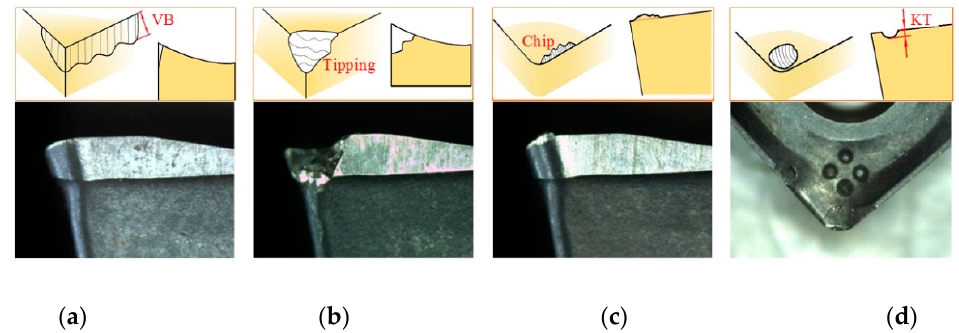
Figure 6. Form of tool wear and tool breakage ( a ) Flank wear; ( b ) tool breakage; ( c ) adhesive wear; ( d ) rake face wear.